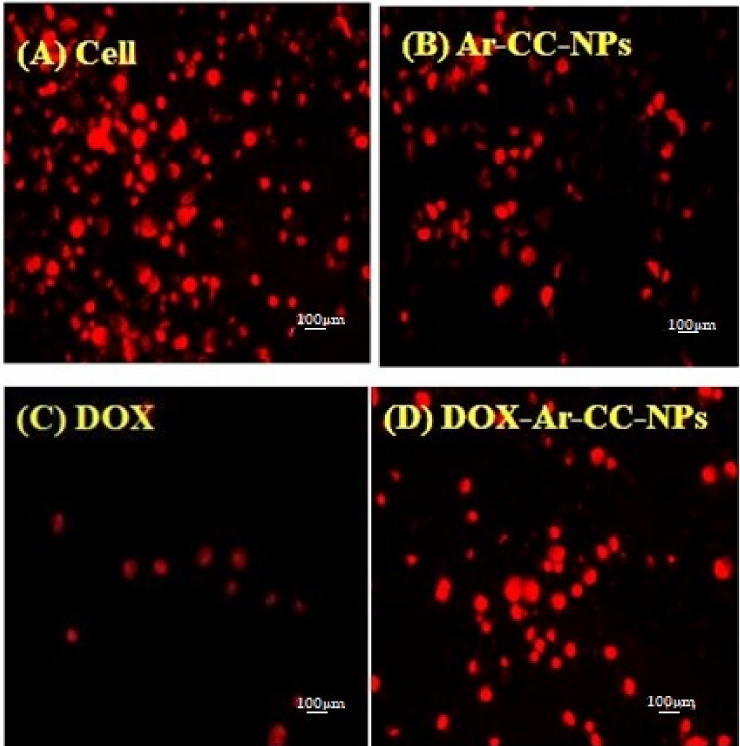
Figure 1. Cellular uptake study. ( A ) Control cells with a red dot showing DOX. ( B ) Cells treated with Ar-CC-NPs. ( C ) Cells treated with DOX. ( D ) Cells treated with DOX-Ar-CC-NPs ( ×